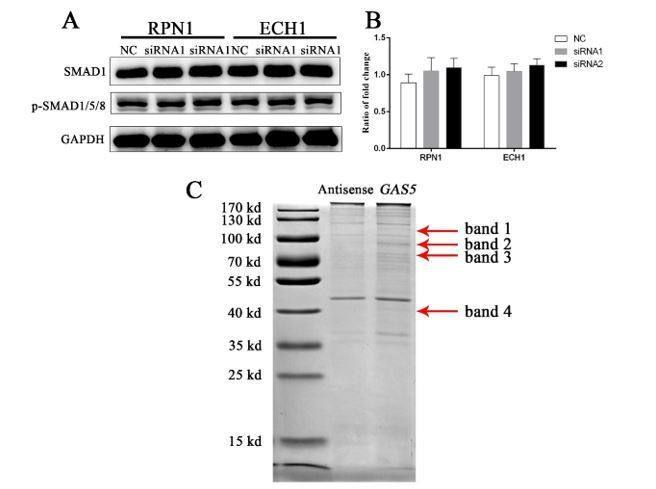
Functional verification of 2 genes and 4 bands in the MMS.A) SMAD1/5/8 pathway changes after siRNA knockdown of the two selected proteins. B) Quantification of western blot for two proteins. C) The bands which selected for the mass spectrum (red arrow). RPN1: ribophorin I. ECH1: enoyl-CoA hydratase 1.